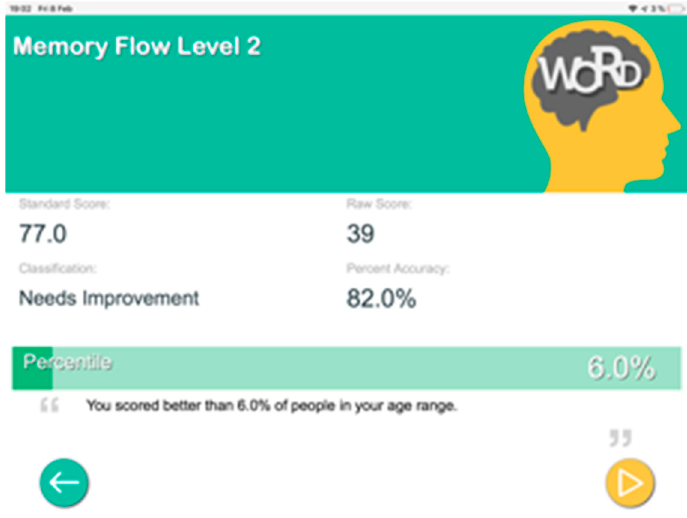
Figure A3. An example of the results of testing